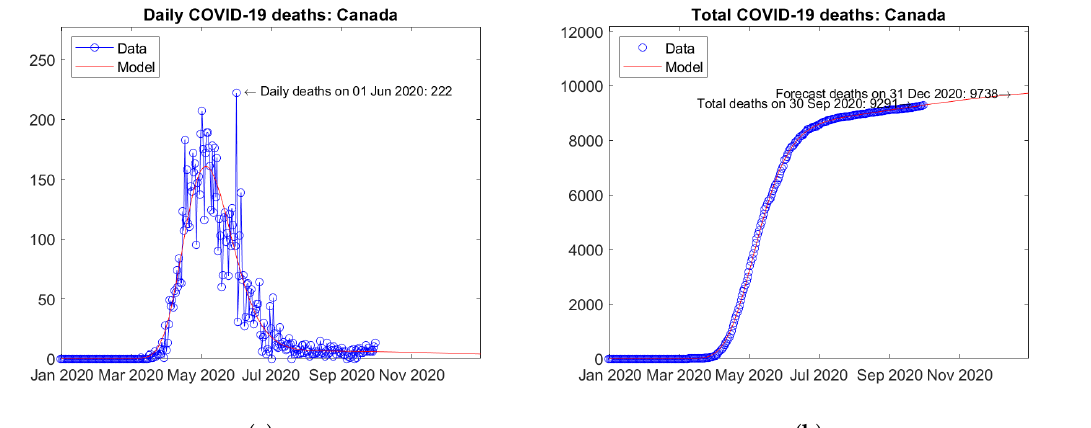
Figure 19. Actual and predicted trends in Canada: ( a ) daily deaths, ( b ) total deaths.